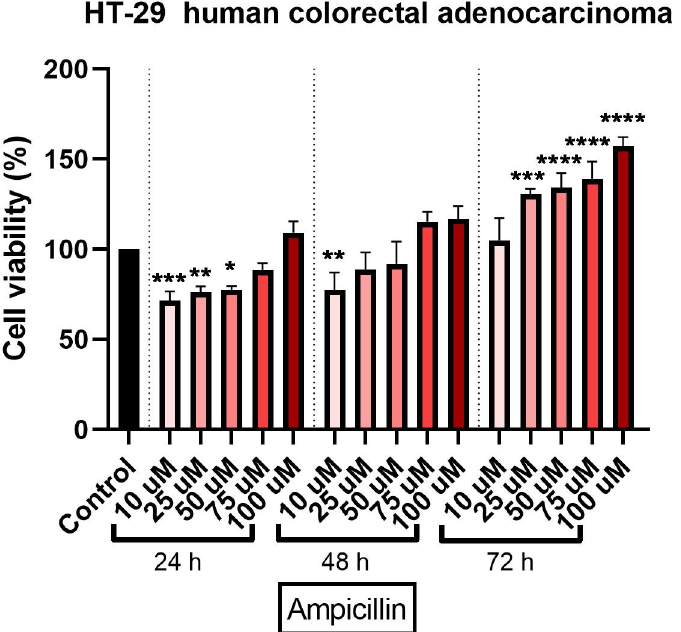
Figure 2. In vitro assessment of ampicillin’s (10, 25, 50, 75, and 100 µM) effect on cell viability in human colorectal adenocarcinoma (HT-29) cells. The results are expressed as cell viability percentage (%) normalized to control cells and were determined by MTT assay at 24-, 48-, and 72-h intervals. The data represent the mean values ± SD of three independent experiments performed in triplicate. One-way ANOVA analysis was applied to determine the statistical differences in relation to con-trol followed by Dunnett’s multiple post-test comparisons (* p < 0.05, ** p < 0.005, *** p < 0.001, and **** p < 0.0001).